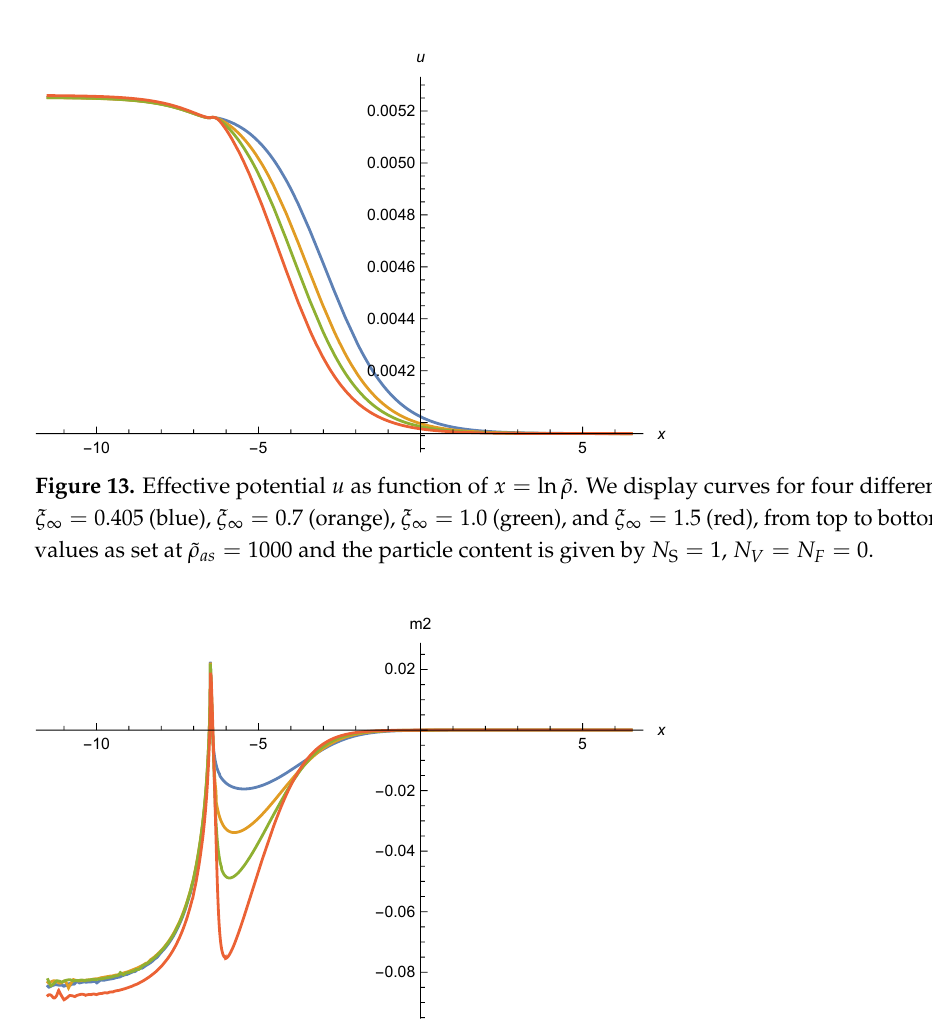
Figure 14. Mass term u (cid:48) as function of x = ln ˜ ρ . Parameters and color coding is the same as for Figures 13 and 15. We observe strong variations in the transition region of x between − 7 and − 5. The negative u (cid:48) ( ρ → 0 ) corresponds to a maximum of the potential at the origin. The small local minimum of u at x ≈ − 6.5 may be an artifact of the